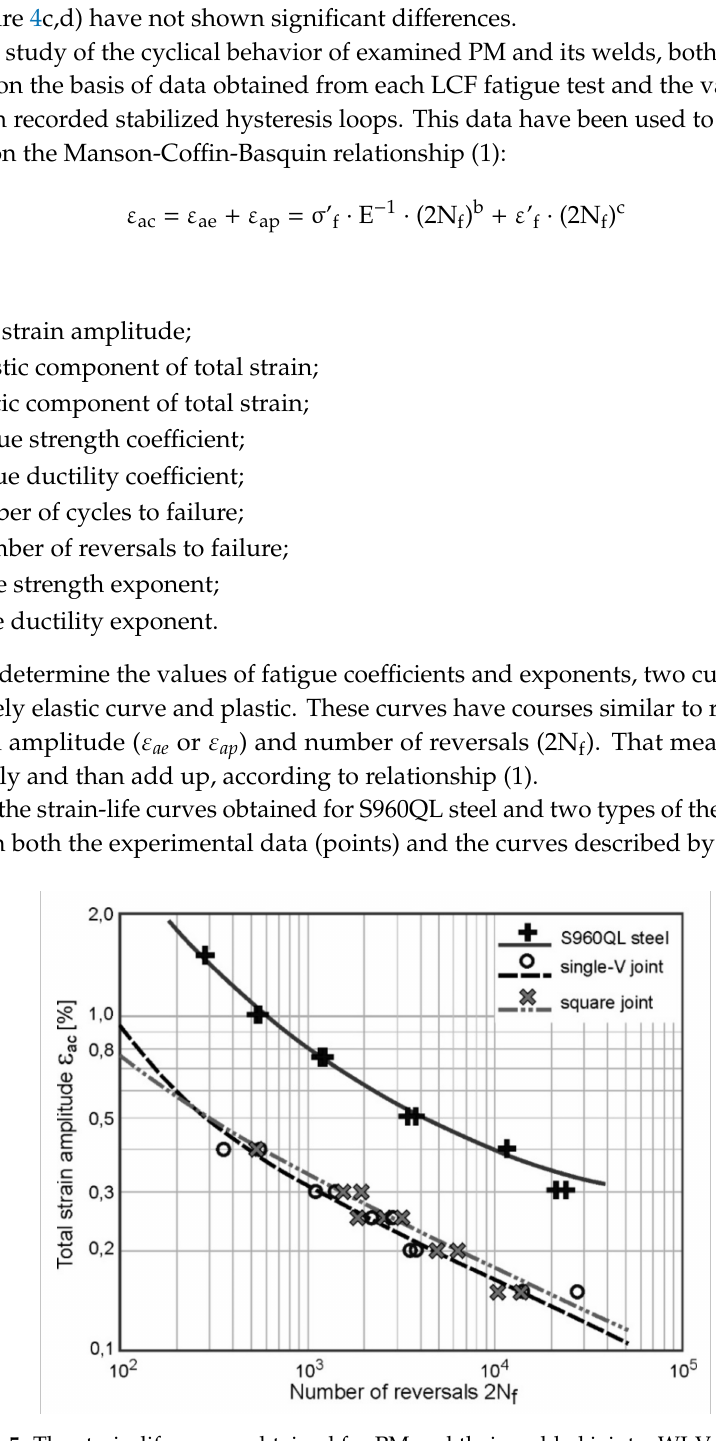
Figure 5. The strain-life curves obtained for PM and their welded joints: WJ-V and WJ-S. Determined values of individual coe ffi cients and the corresponding exponents, both for PM and welded joints WJ-S and WJ-V, are summarised in Table 3. There are also the values of the correlation coe ffi cient R 2 corresponding to particular groups of parameters